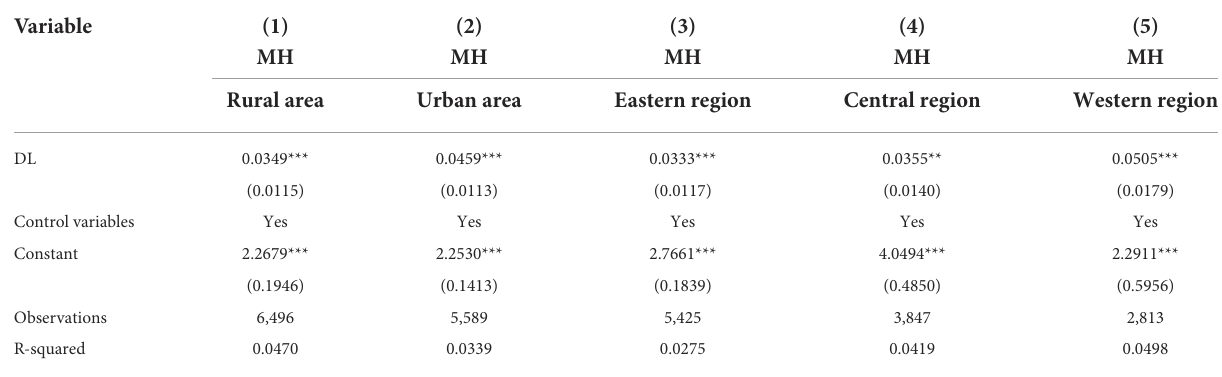
TABLE 6 The regression results of the subgroup